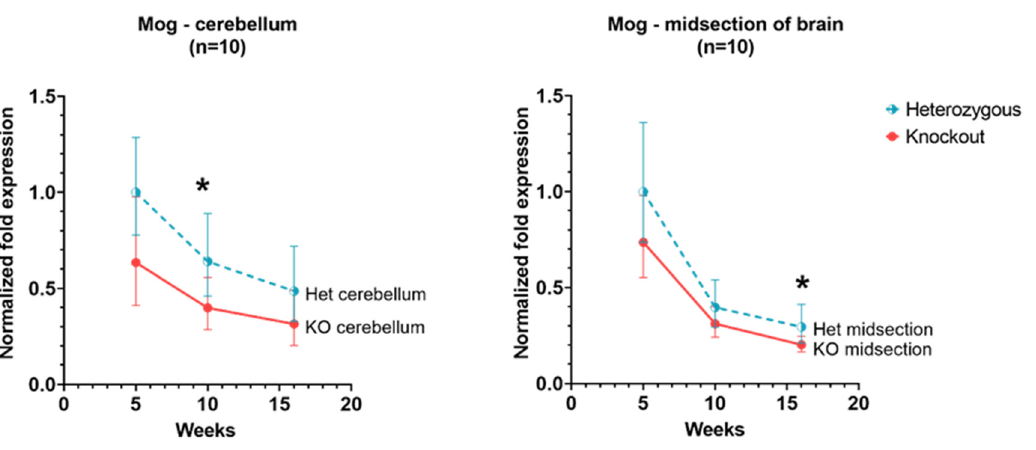
Figure 4. Relative Mog expression in the cerebellum and cerebral cortex of Hexb -KO Sandhoff disease mouse model (*— p value < 0.05; midsection of brain represents cerebral cortex).